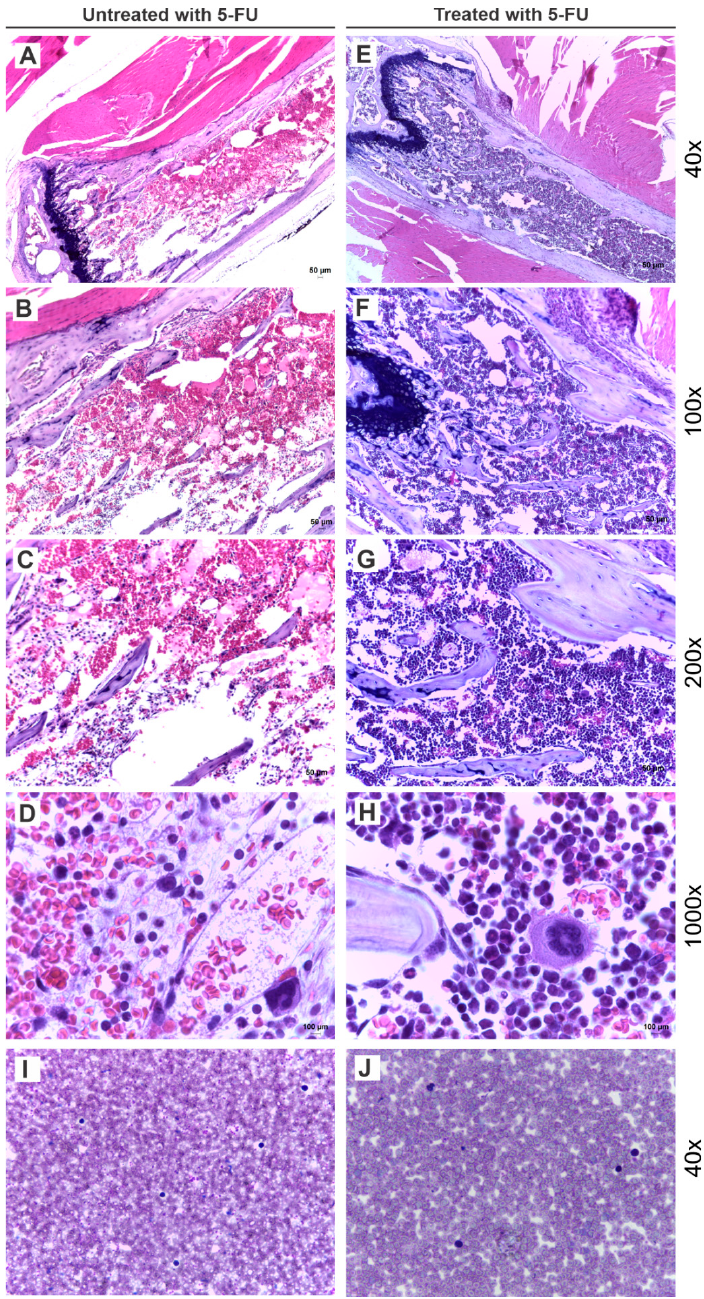
Figure 2. 5-FU effects in bone marrow (BM) cellularity. H&E staining from BM of control animals (untreated with 5-FU) in different magnifications (40×, 100×, 200×, and 1000× respectively) ( A – D ). H&E staining from BM of animals treated with 5-FU 4 days after their administration in different magnifications (40×, 100×, 200×, and 1000× respectively) ( E – H ). Peripheral blood (PB) smear from control animal magnified 40× ( I ). PB smear from animal 4 days after 5-FU administration magnification 40× ( J ).